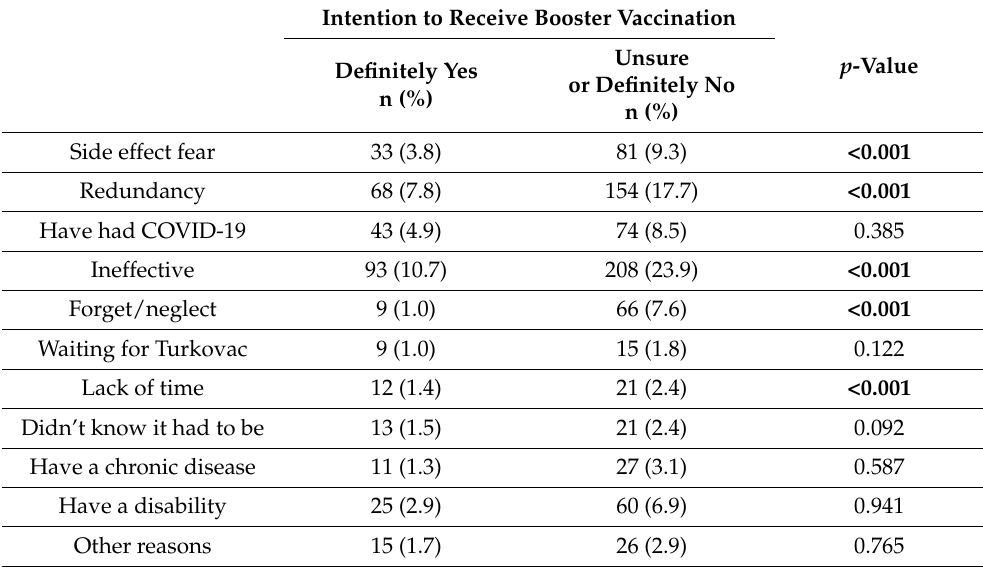
Table 1. Distribution of the reasons why the participants did not receive the booster dose of COVID-19.